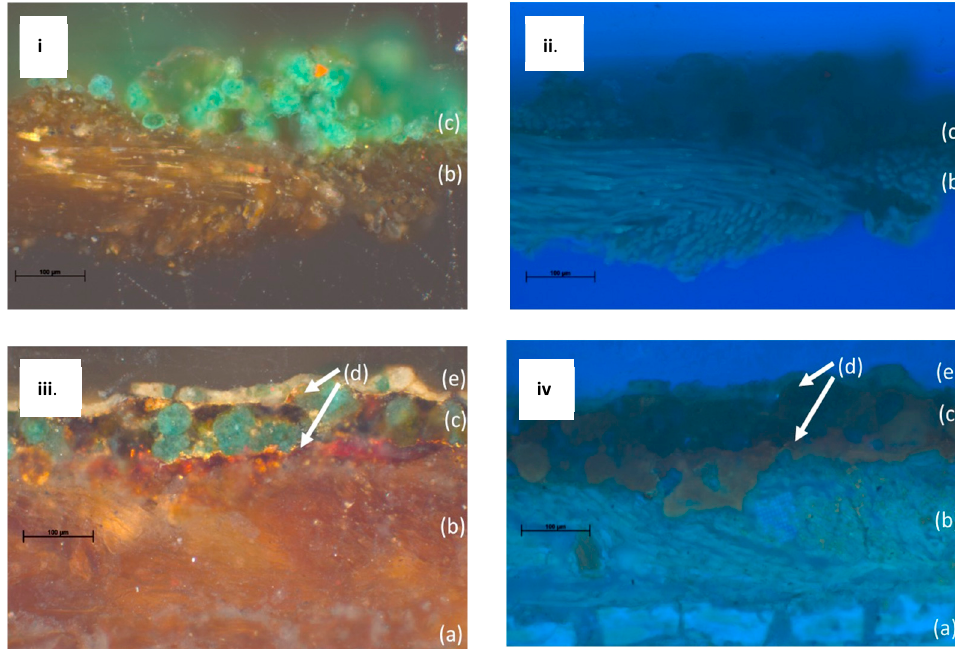
Figure 3. Cross-sectional images of LXT-04 ( i ) and LXT-05 ( iii ) in normal light and LXT-04 ( ii ) and LXT-05 ( iv ) in ultraviolet light: the layered structure of both the first and second generations is ( a ) the paper support, ( b ) the silk substrate, ( c ) green paint, ( d ) the gold leaf, and ( e ) white paint. Scrapings from the pigmented layers were analyzed with polarized light. In plane- polarized light, the pigment particles appear as a fine mesh of translucent green, rounded crystals. They were in high relief with a lower Refractive Index (RI) than the medium (Figure 4i). Under crossed polars, the samples have moderate birefringence. Some parti- cles appear to be second-order interference colors (Figure 4ii), which indicates the pres- ence of atacamite [11,12]. . Figure 4. Dispersed sample of the pigments from LXT-04 at 500× magnification in ( i ) plane polar- ized transmitted light and ( ii ) crossed-polarized light. The cross sections were studied with SEM-EDX to determine the elemental distribu- tion across the layers (Figure 5). The data show the presence of copper and chlorine map- ping together within the pigment particles from the two generations. In both samples, calcium and sulfur were detected within the textile fibers. In addition, for LXT-04, potas- sium and silicon were mapped within the areas of some slightly transparent particles in the paint layer. For LXT-05, the upper white paint layer is rich in lead.